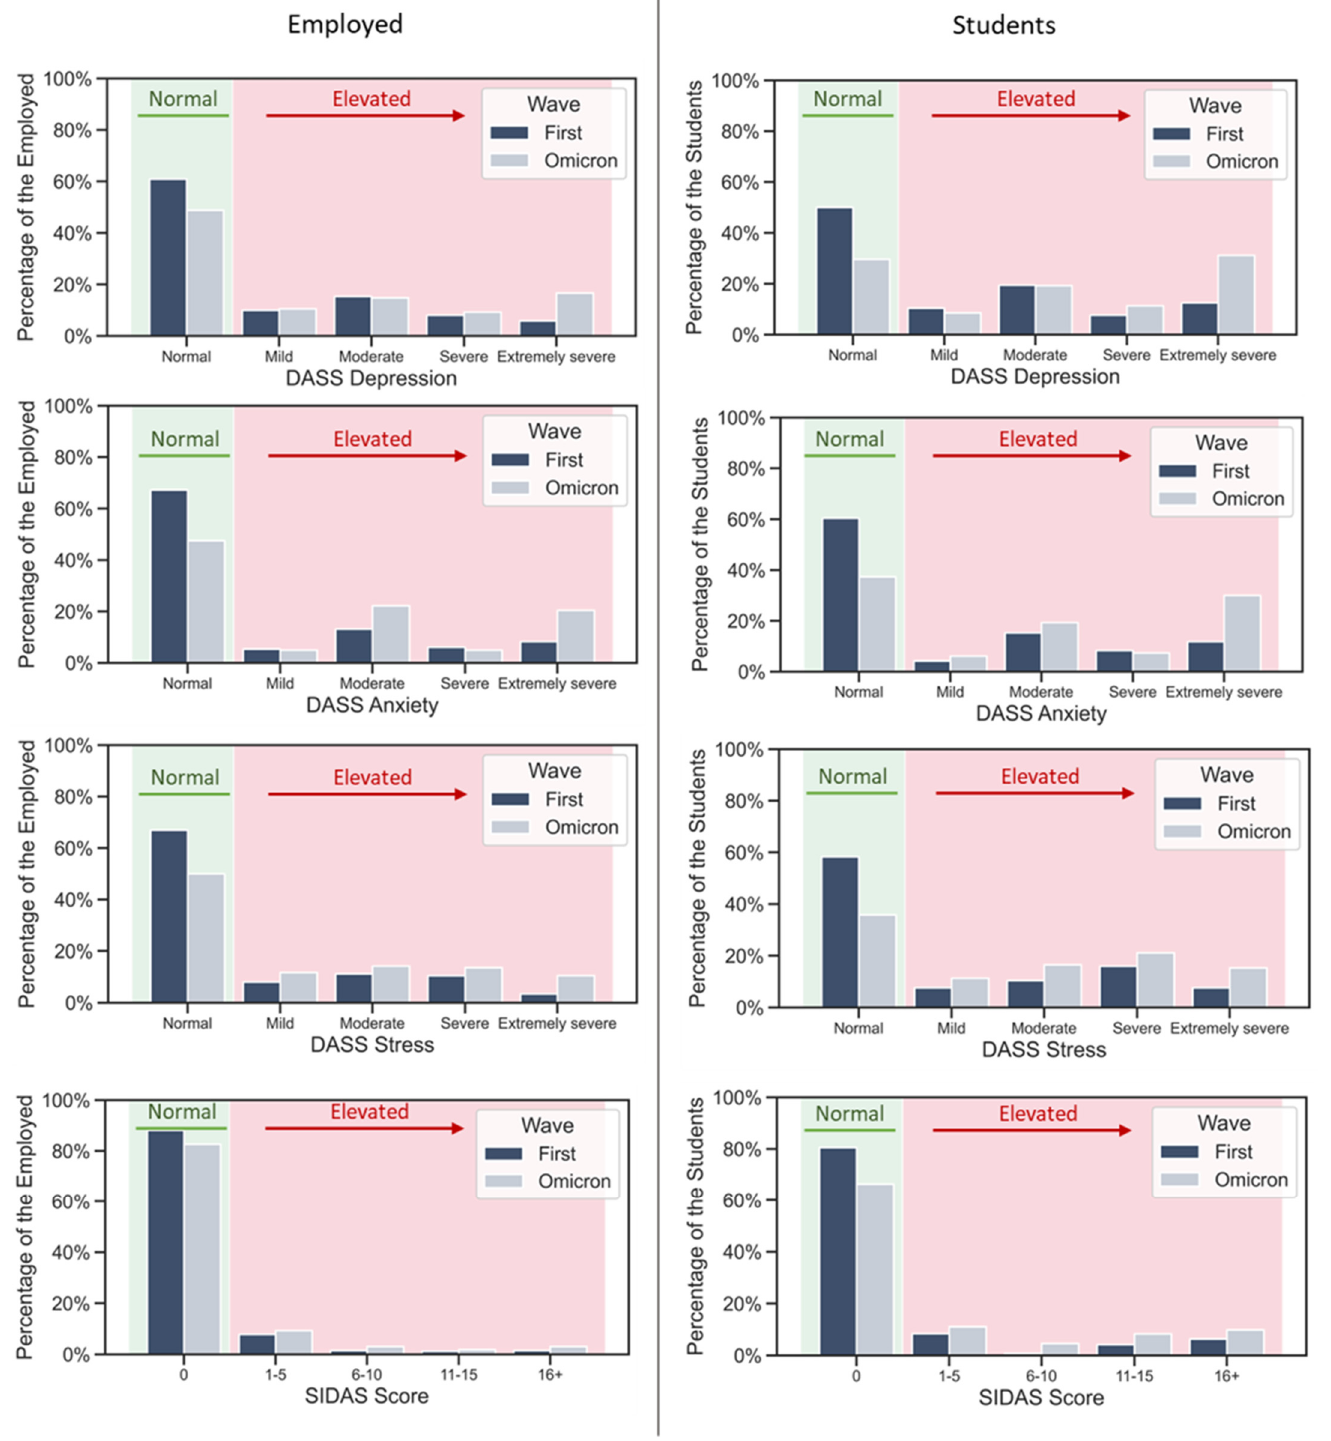
Figure 2. Distribution of DASS Depression, DASS Anxiety, DASS Stress, and SIDAS scores by category in the first and the Omicron wave, among the employed respondents and the students. Both employed respondents and students exhibited the same trend of increased scores in the Omicron